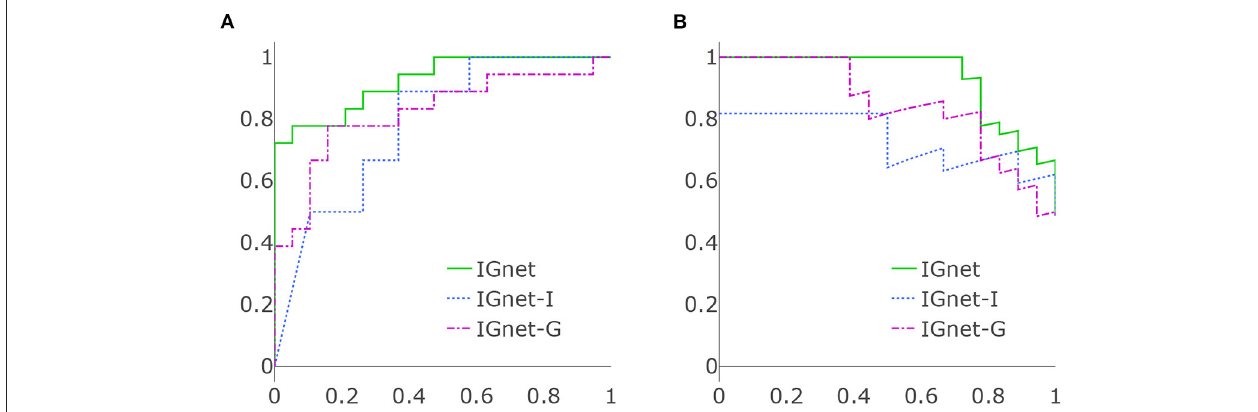
FIGURE 4 | (A) ROC curves of IGnet, using both imaging and genetic inputs; IGnet-I, using imaging input alone; and IGnet-G, using genetic input alone. (B) PRC curves of IGnet, IGnet-I, and